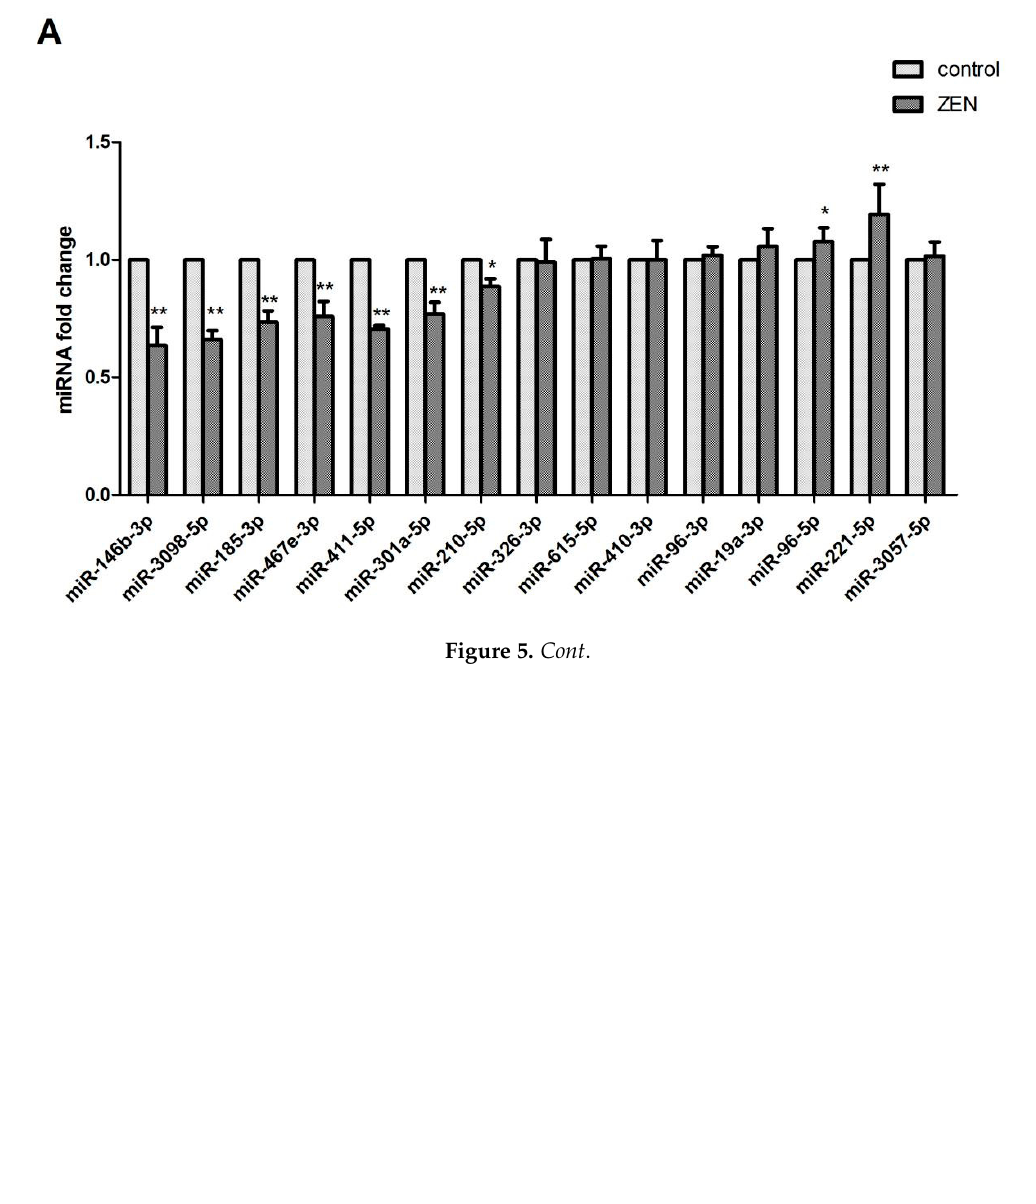
Figure 5. ( A ) Validation of the differentially expressed miRNAs. ( B ) Verification of the miRNA target genes. The qRT-PCR analyses of the mRNA expression levels ofmiR-146b-3p, miR-3098-5p, miR-185-3p, miR-467e-3p, miR-411-5p, miR-301a-5p, miR-210-5p, miR-326-3p, miR-615-5p, miR-410-3p, miR-96-3p, miR-19a-3p, miR-96-5p, miR-221-5p, miR-3057-5p, PTEN, AKT1, AKT2, AKT3, H-ras, N-ras, K-ras, Rap1a, Rap1b, Foxo1, Foxo3, Foxo4, and Foxo6 in the control and ZEA-exposed TM3 Leydig cells. The gene expression levels represent the mRNA expression levels relative to the control levels (the values represent mean ± SD). The asterisks are used to indicate a statistically significant difference: * p < 0.05; ** p < 0.01. 2.5. Verification of the miRNA Target Genes